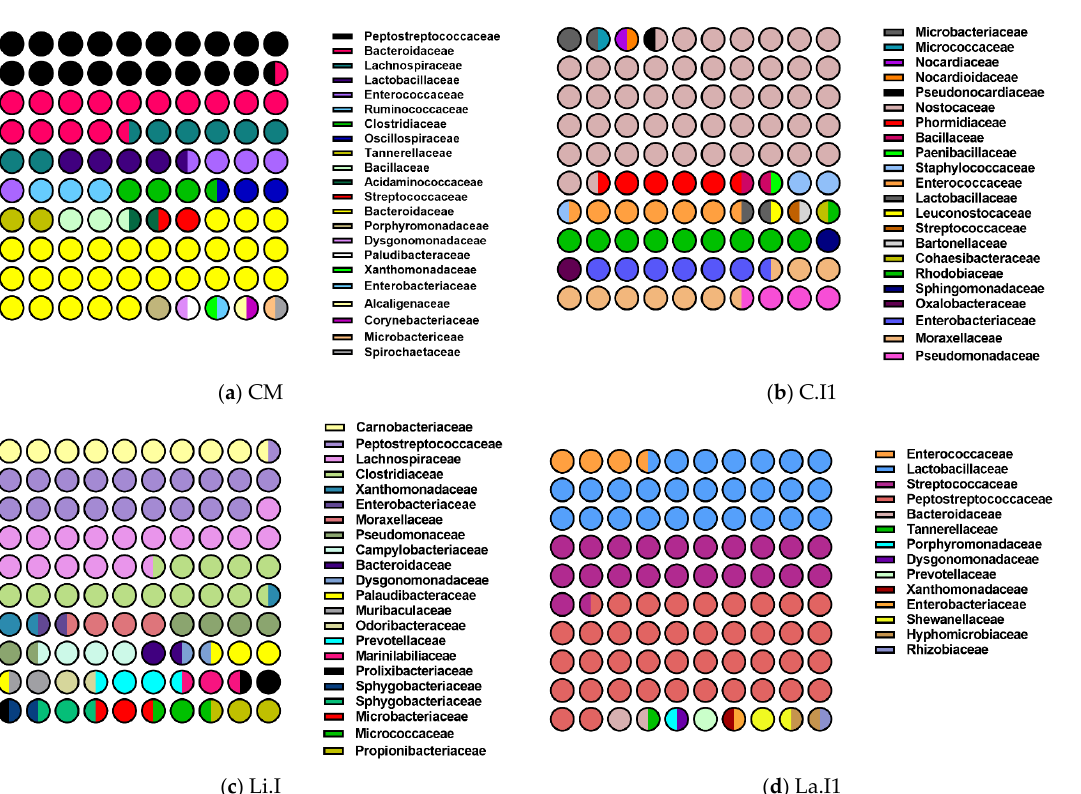
Figure 5. Graphs showing the abundances of bacterial communities at the family level in cattle manure (CM) ( a ) and three inocula: C.I1 ( b ), Li.I ( c ), and La.I1 ( d ), based on the 16S rDNA sequencing data using Nanopore workflow. The square represents the whole percentage (100%) and the cycle represents 1%, which indicates the total of cycles in each color and provides information on the percentage of the family.